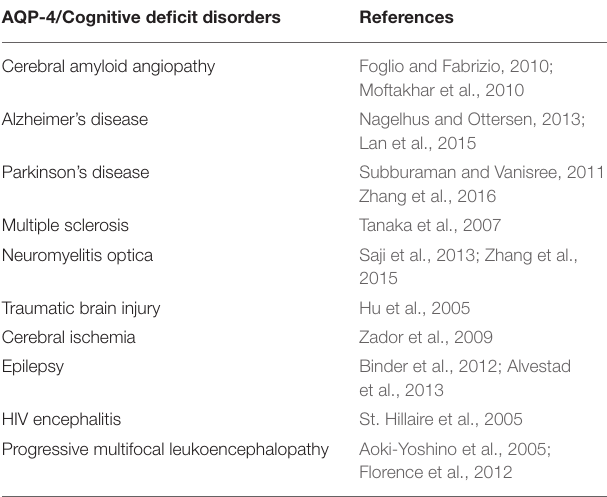
TABLE 1 | Disorders associated with cognitive deficit and AQP-4 up-regulation.